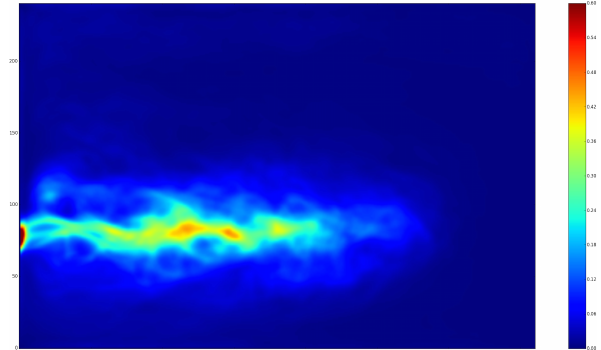
Figure A1. Surface eddy kinetic energy averaged over 1 year (in m 2 s − 2 ), for the SEABASS configuration at a 1/12 ◦ horizontal res-